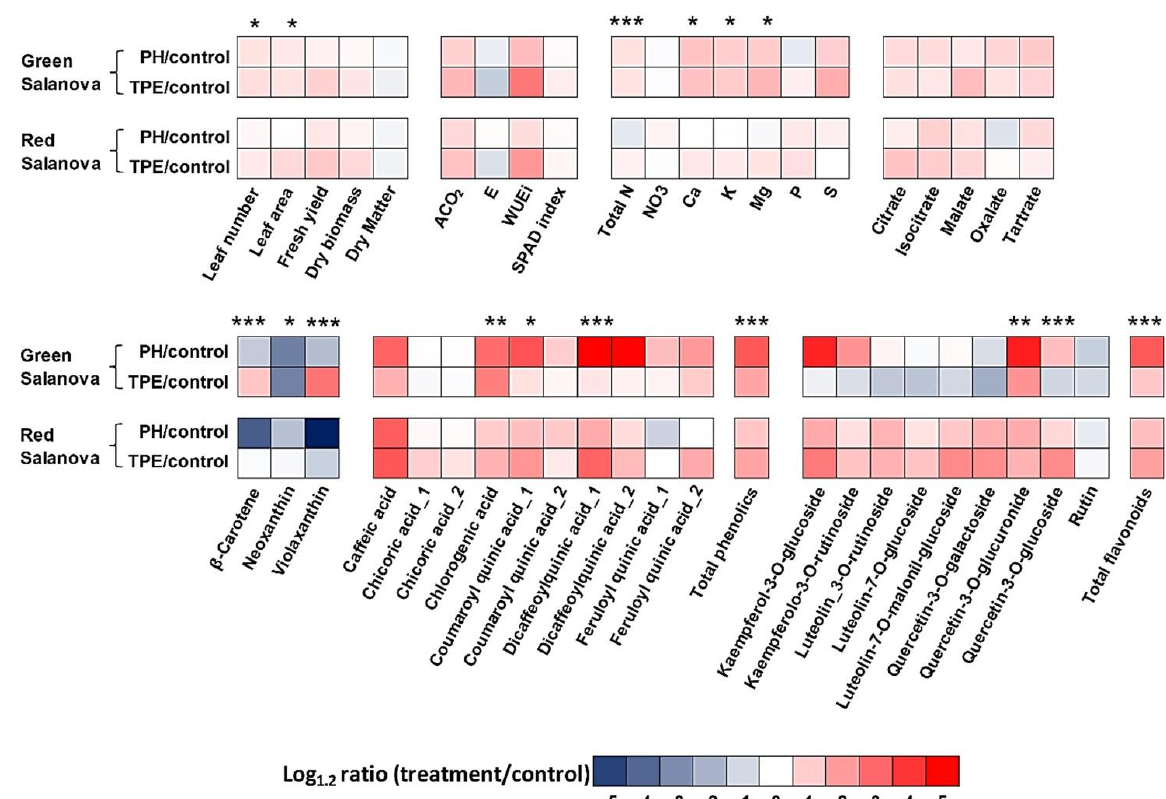
Figure 1. Heat map analysis summing up the responses of the two lettuce cultivars (green and red salanova) to the two biostimulant treatments (PH and TPE). Results were calculated as logarithm base 1.2 (Log 1.2 ) ratio of biostimulant treatments (PH or TPE) to control plants that were not treated with biostimulants. Results are visualized using a false color scale with red indicating an increase and blue a decrease, whereas white squares indicate no differences. *, **, and *** indicate results significant at p < 0.05, 0.01, and 0.001, respectively. PH : Trainer ® , TPE : Auxym ® .